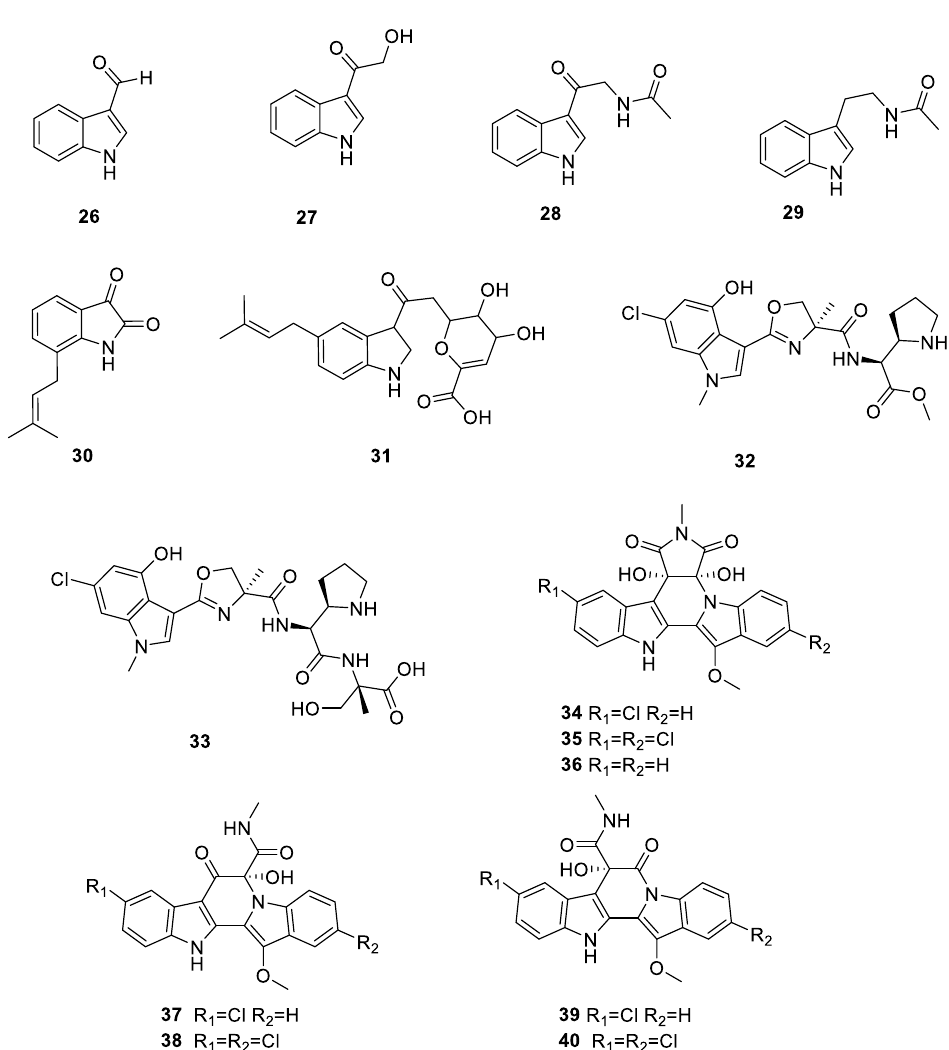
Figure 5. Chemical structures of compounds 26 − 40 from lichen-associated actinomycetota.